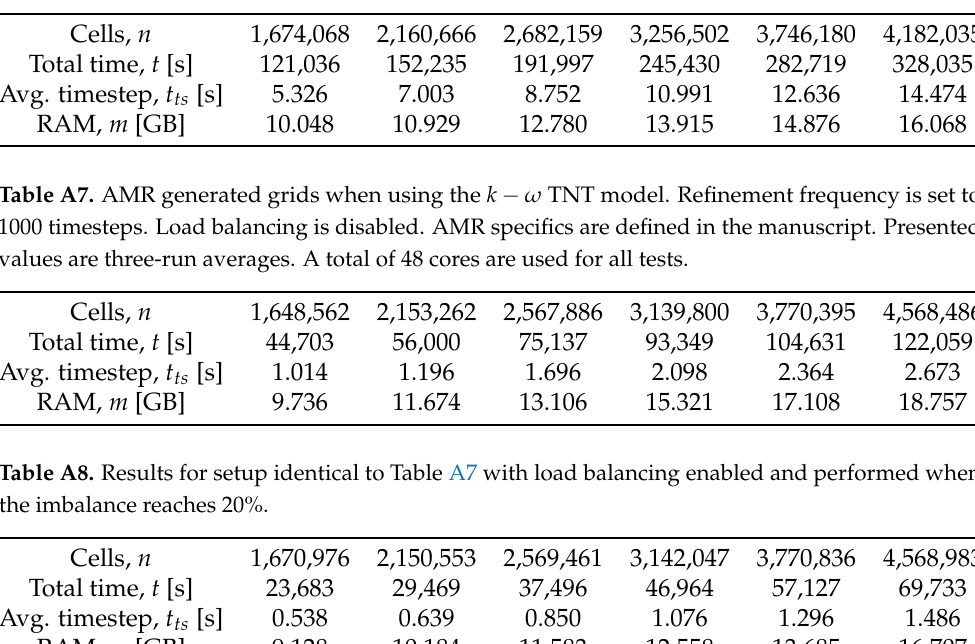
Table A6. Results for setup identical to Table A5 with load balancing enabled and performed when the imbalance reaches 20%.